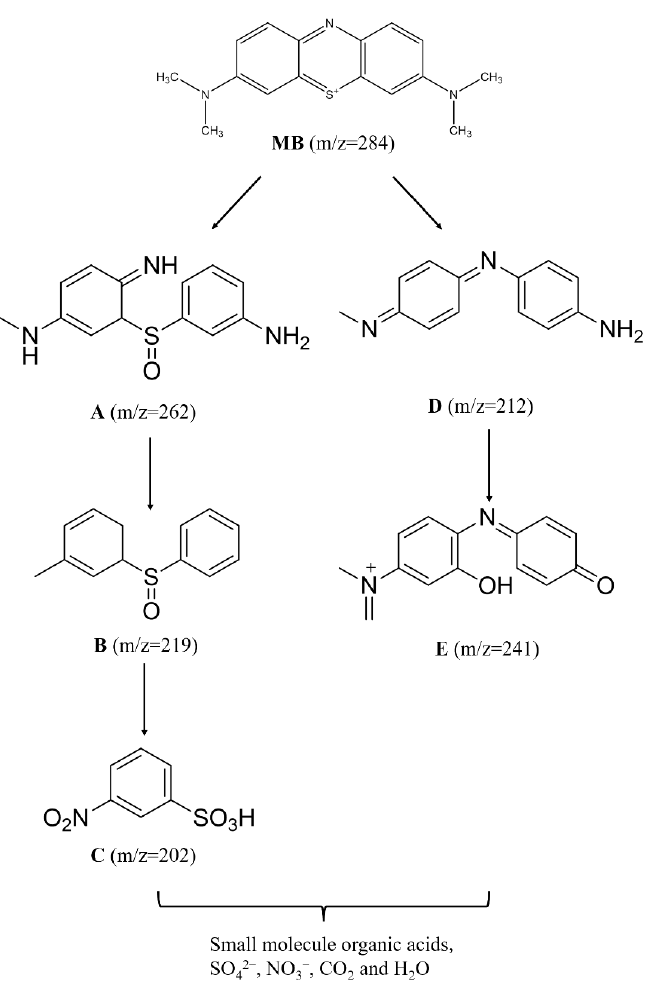
Figure 13. Possible pathways of MB degradation in MCA-CN/WO 3 /H 2 O 2 /visible light system.